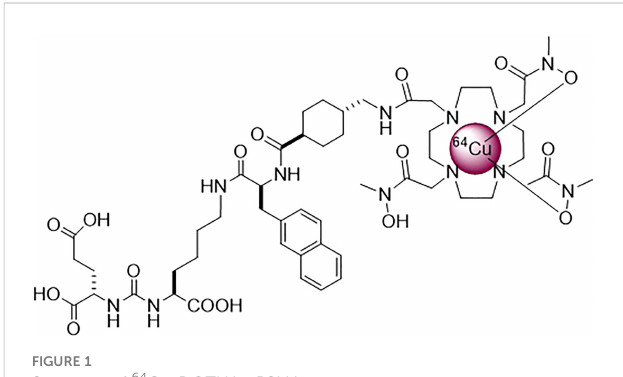
FIGURE 1 Structure of 64 Cu-DOTHA 2